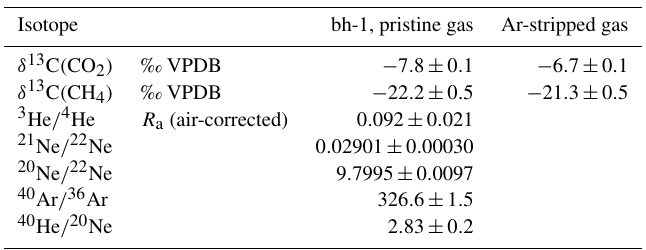
Table 2. Noble gas isotope ratios and δ 13 C of CO 2 and CH 4 of bh-1 pristine geogenic gas as well as the carbon isotope ratios determined in the Ar-stripped gas of D5 from the salt-pillar. Error limits are 2 σ